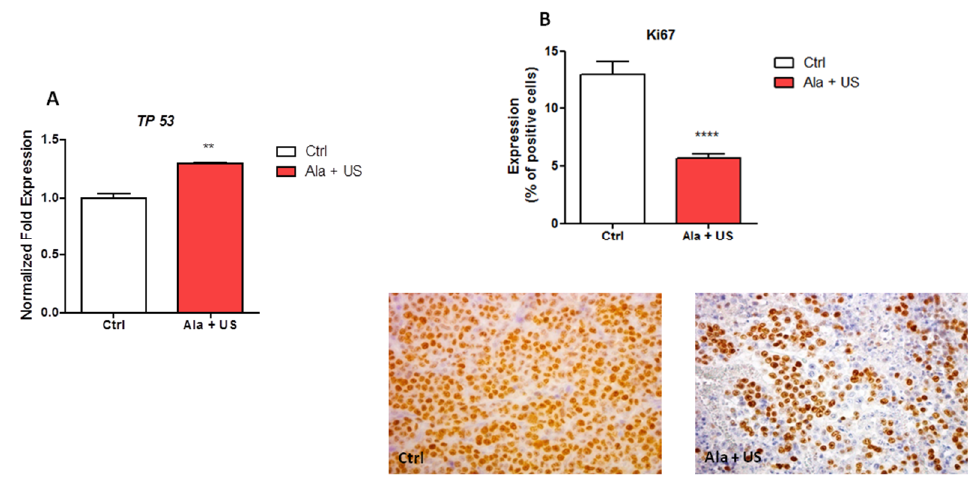
Figure 3. TP53 mRNA expression and Ki67 protein expression after SDT. Control and experimental groups were either treated with a saline iv injection into the tail vein (0.5 mL), an Ala iv injection into the tail vein (375 mg/kg bw), US alone (1.5 W cm 2 , 1.8 MHz, 300 s), or Ala and US (1.5 W cm 2 , 1.8 MHz for 300 s, at 4 h after the Ala 375 mg/kg bw iv injection, SDT group). ( A ) Analysis of TP53 mRNA expression by real-time RT-PCR at 72 h after SDT. RRN18S was used as a reference gene to normalize the data (mRNA levels were compared with those of the control group, which are stated as 1). ( B ) Ki67 protein expression by immunohistochemistry at 72 h after SDT (day 11), and representative Ki67 immunostaining (hematoxylin counterstain, original magnification ×400). Statistical significance vs. untreated tissue (Ctrl): ** p ≤ 0.01, **** p ≤ 0.0001.